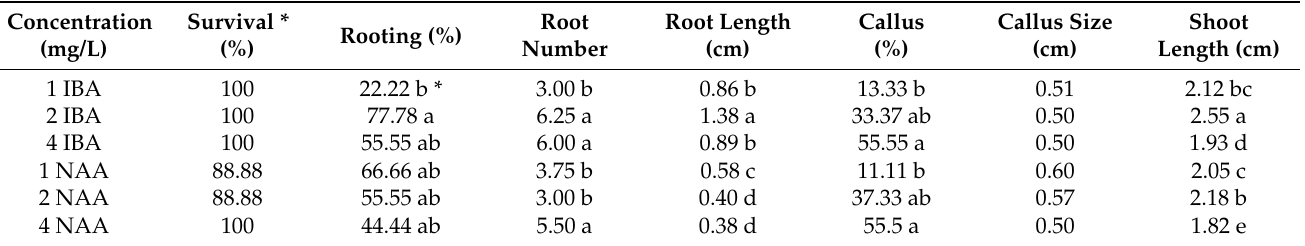
Table 5. The effects of auxins (IBA and NAA) on the rooting of in vitro-raised microshoots of YV2 on the WPM medium.